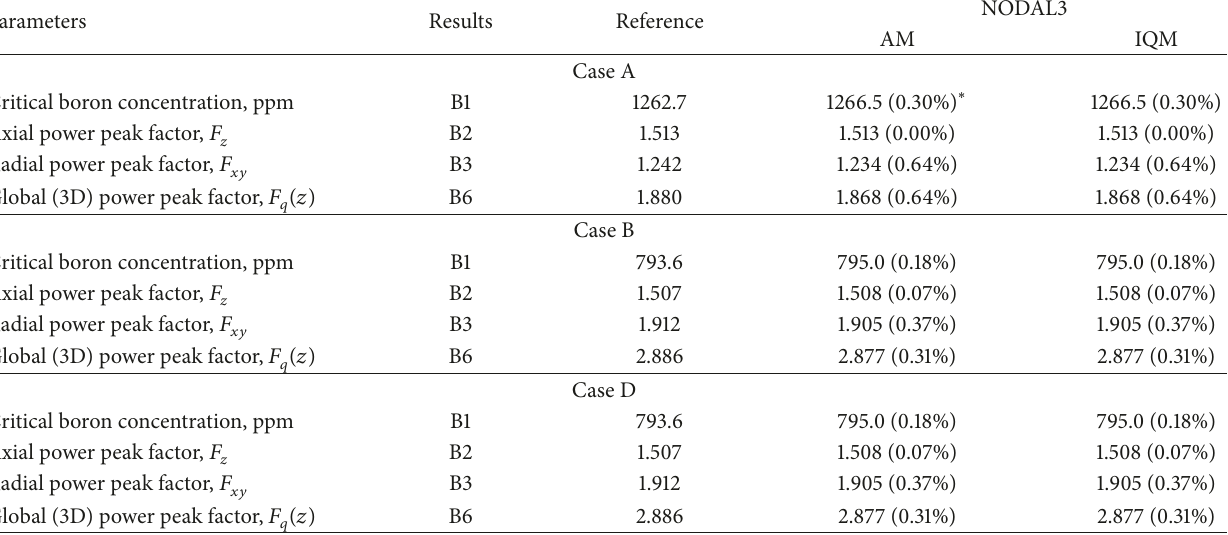
Table 1: Steady-state results for Cases A, B, and D.